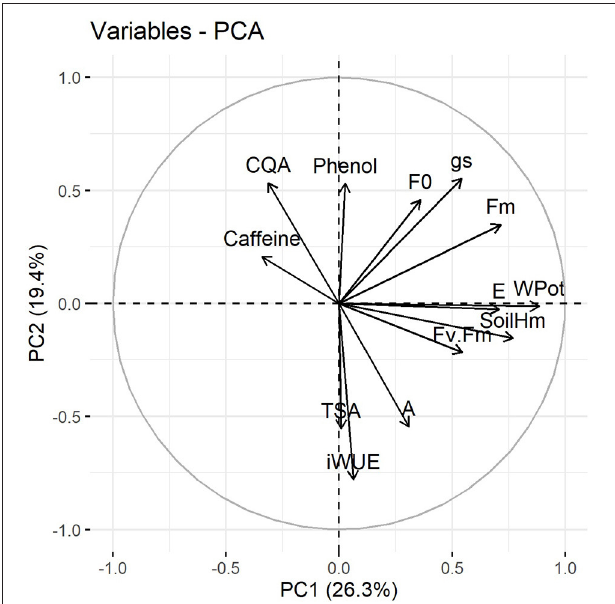
FIGURE 6 | Principal component analysis of physiological and biochemical variables of C. arabica plants exposed to ambient [CO 2 ] under well-watered and water deficit (a[CO 2 ] + WW and a[CO 2 ] + WD, respectively) and elevated [CO 2 ] under well-watered and water deficit (e[CO 2 ] + WW and e[CO 2 ] + WD, respectively) conditions on day 0, 20, and 40 after water deficit imposition in the OTC. Numbers in parentheses give the per cent variation explained by the first and second principal component. Variables abbreviation: CQA, 5-CQA; Phenol, Total phenolic compounds; WPot, Leaf water potential; Fv.Fm, F v /F m ; SoilHm, Soil moisture.